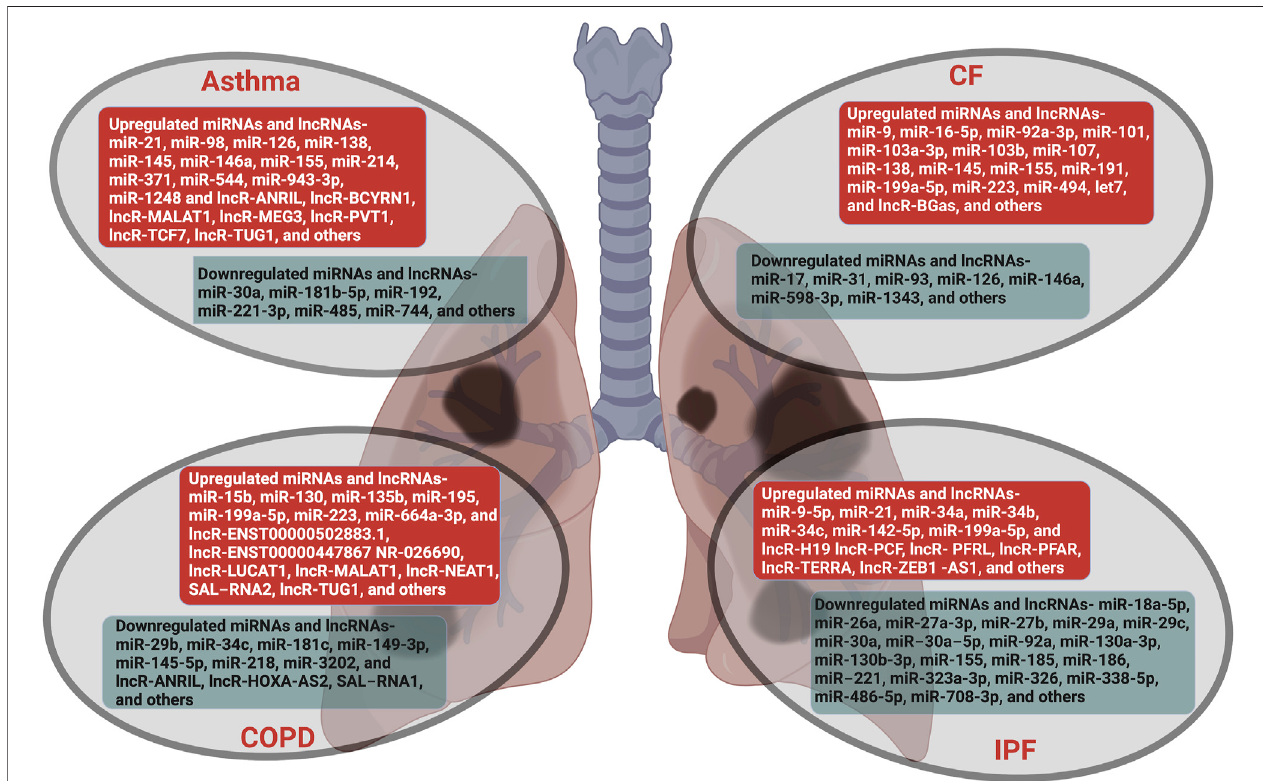
FIGURE 1 | Lung diseases regulated by non-coding RNAs. The miRNAs and lncRNAs that are aberrantly expressed in lung diseases such as asthma, COPD, CF and IPF are listed. The ncRNAs that are upregulated are in red boxes and those that are downregulated are in green boxes.